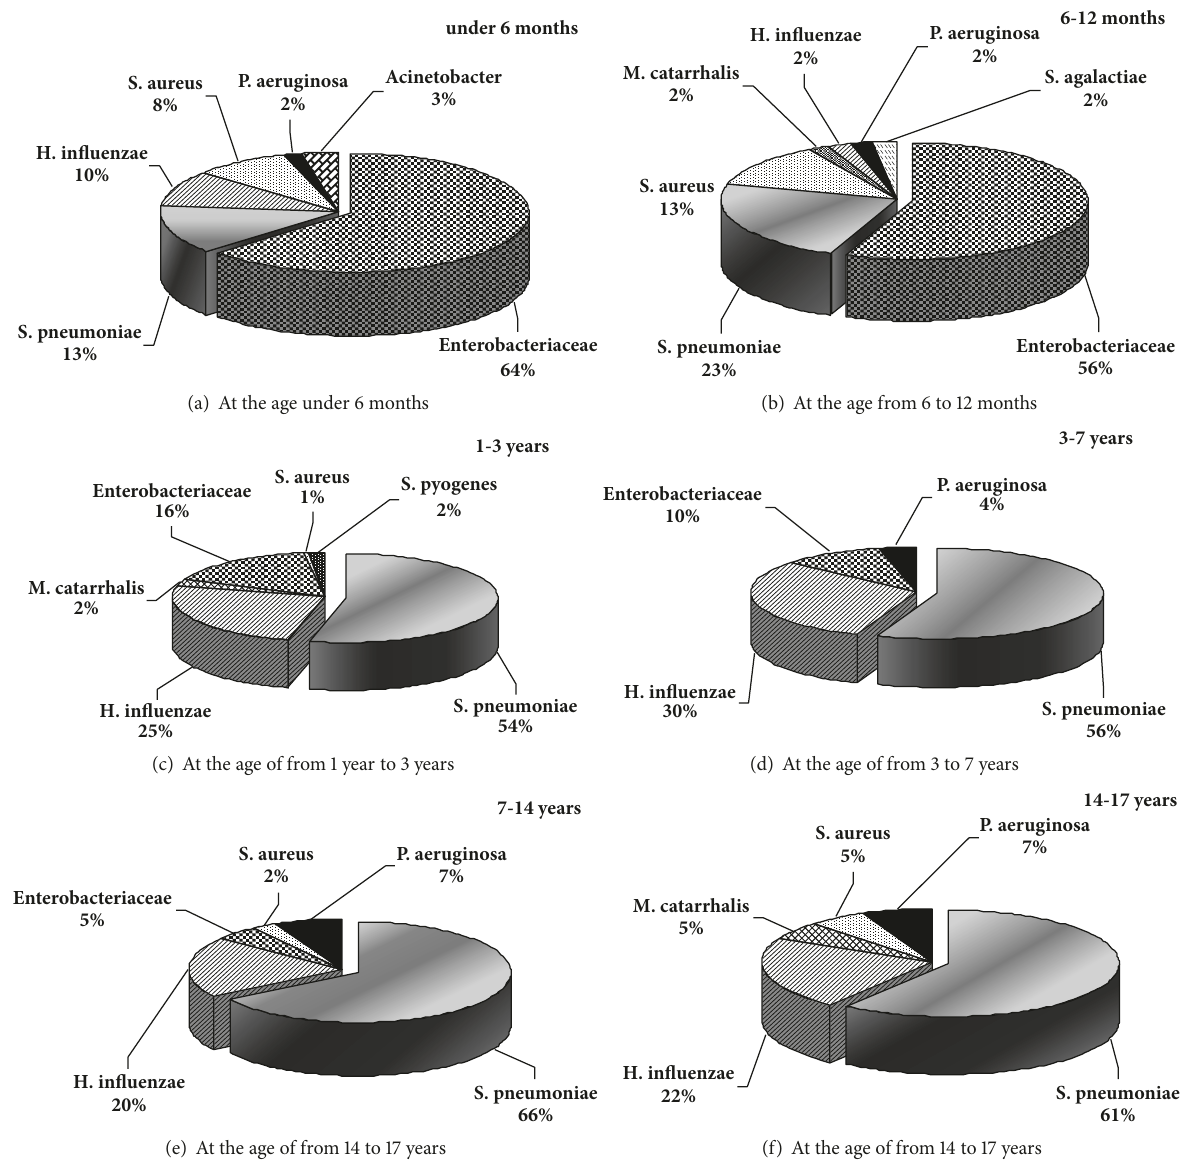
Figure 1: Etiology of pneumonia in different age groups of children (Khabarovsk Territory, %).